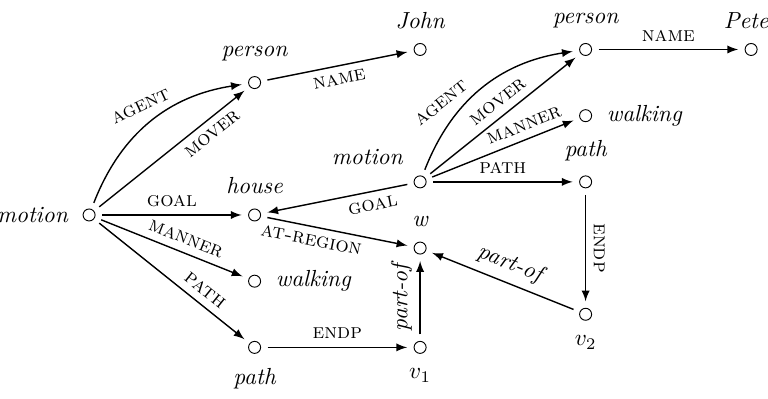
Figure 3: Quantification and node